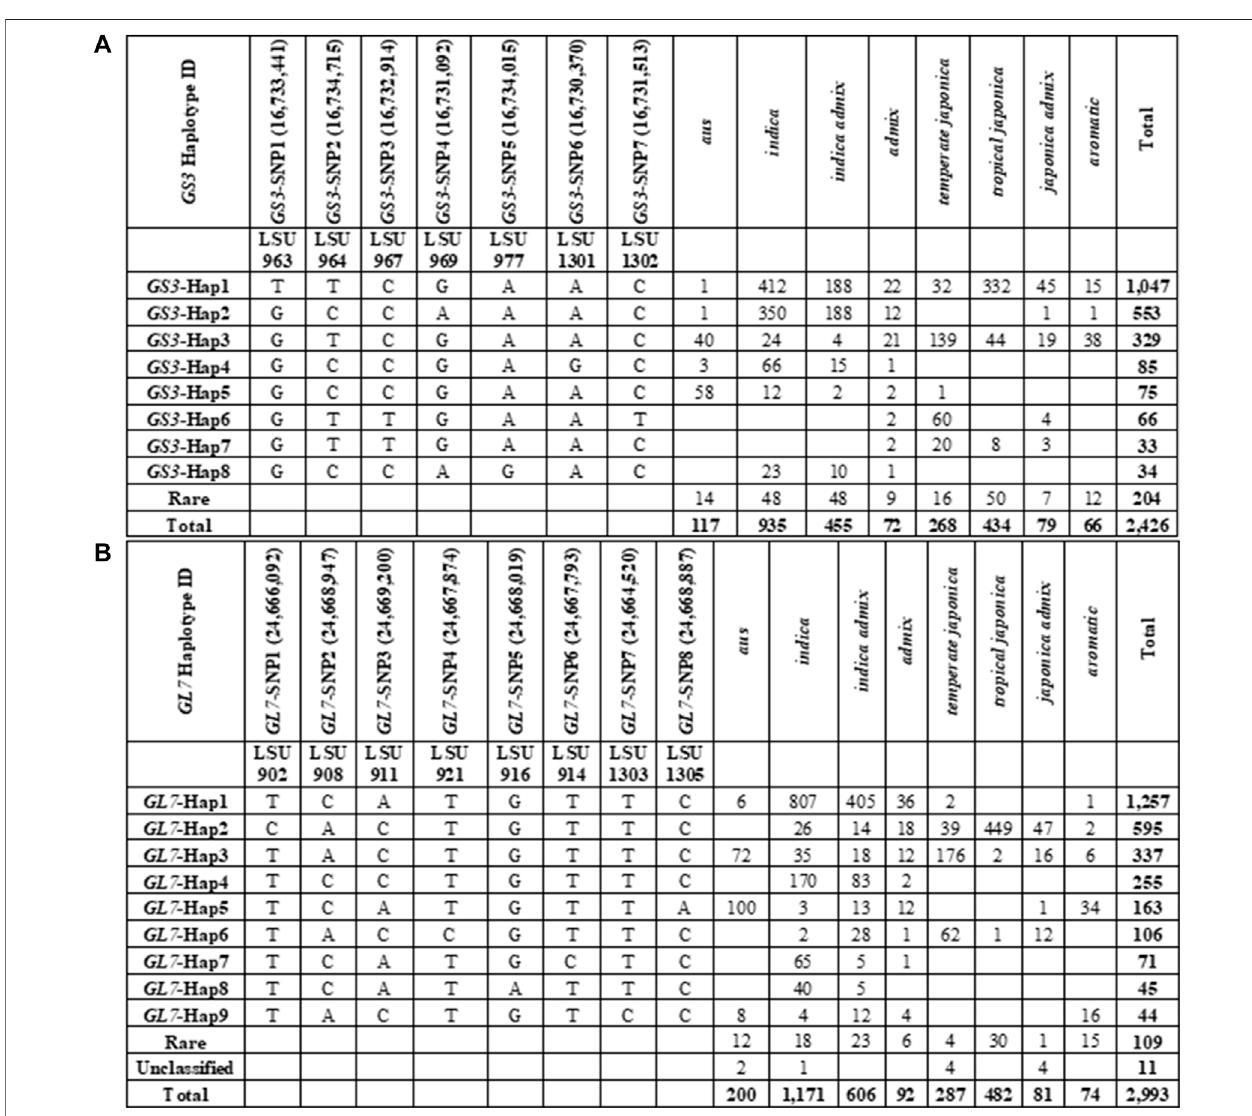
FIGURE 1 | SNP data was obtained from SNP-Seek online portal of the International Rice Research Institute for GS3 and GL7 genes and haplotypes were characterized based on speci fi ed criteria with each gene. (A) Haplotype characterization of the GS3 gene in IRRI SNP-Seek 3K RGP genotype data. (B) Haplotype characterization of the GL7 gene in IRRI SNP-Seek 3K RGP genotype data.